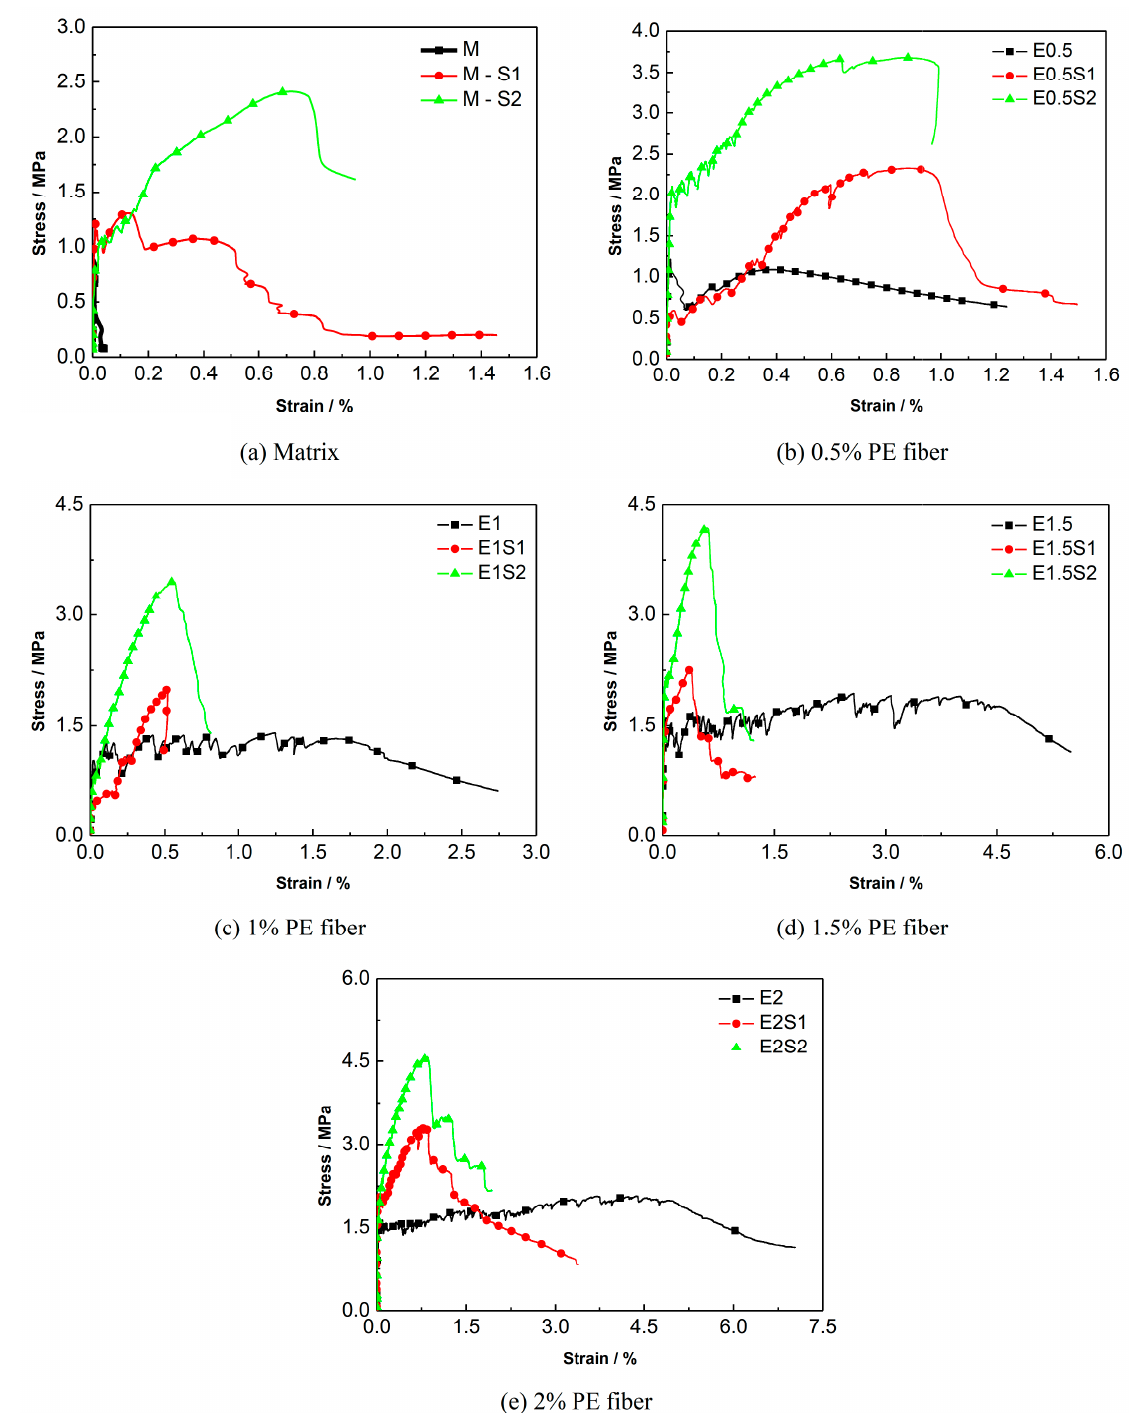
Figure 12. Comparison of stress-strain curves of ECC specimens with di ff erent numbers of steel-grid layers. ( a ) Matrix; ( b ) 0.5% PE fiber; ( c ) 1% PE fiber; ( d ) 1.5% PE fiber; ( e ) 2% PE